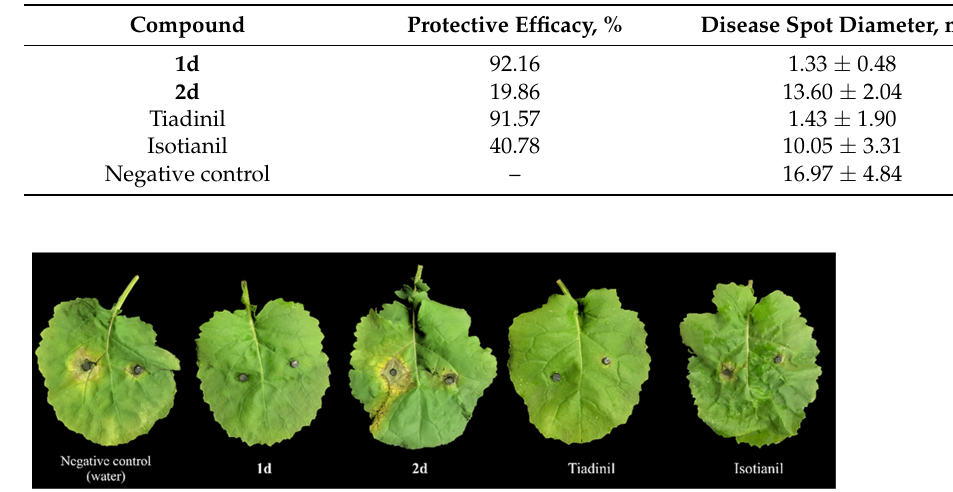
Figure 4. Effects of compound 1d and 2d against A. brassicicola -infected rape